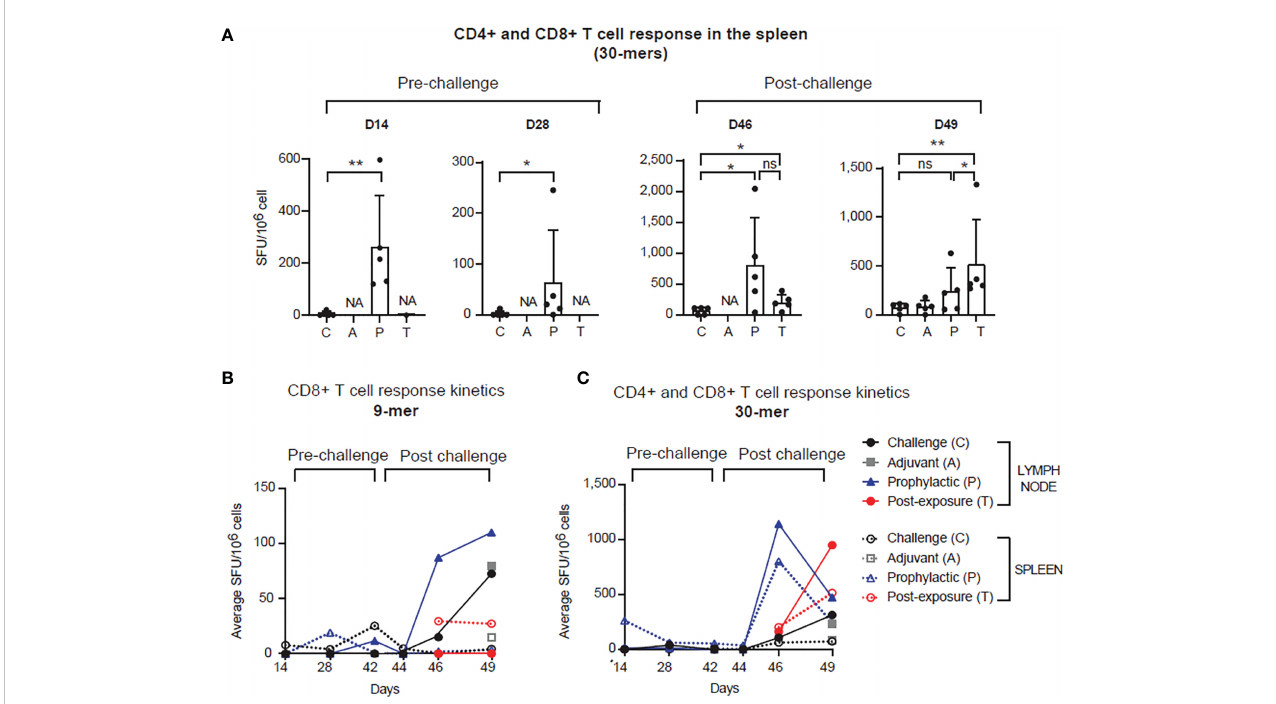
FIGURE 2 PolyPEPI-SCoV-2 induces strong and rapid adaptive T cell immunity pre- and post-infection. (A) PolyPEPI-SCoV-2 induces adaptive T cell immunity in the spleen. Immunogenicity is illustrated on D14, D28, D46 and D49 as mean ± SD spot forming unit (SFU) per 10 6 spleen cells of 5 animals against the 30-mer peptide pool (one-tailed Mann-Whitney test, ns, p>0.05, (*) p<0.05, (**) p<0.01. NA, not-analyzed (response not investigated). (B, C) T cell response kinetics was evaluated on D14, D28, D42 (0 d.p.i.), D44 (2 d.p.i.), D46 (4 d.p.i.) and D49 (7 d.p.i.) against (B) the 9-mer and (C) the 30-mer peptide pools (S, N, M and E peptides pooled together). Data are shown as average SFU per 10 6 spleen cells of 5 animals or SFU per 10 6 pooled lymph node cells (pool of 5 animals per group). Response to 9-mer represents mainly CD8+ T cell while response to 30-mer depicts combined CD4+ plus CD8+ T cell